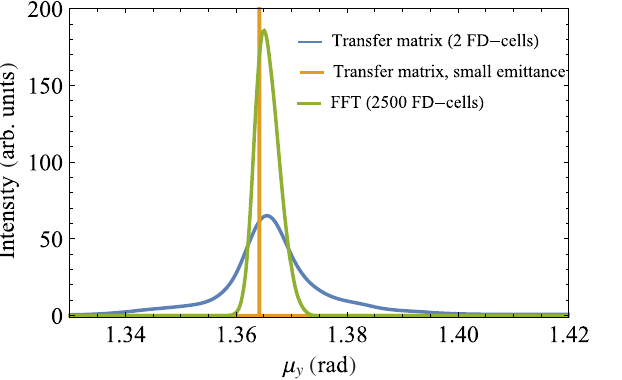
FIG. 12. Spectrograms of the transverse phase advance for a particle distribution accelerated in a dual pillar APF structure with 0 . 8 μ m period length. Increasing the FD-cell length along the structure in accordance to the increasing energy keeps the phase advance distribution almost constant (left). A constant FD-cell length, however, leads to a decreasing phase advance